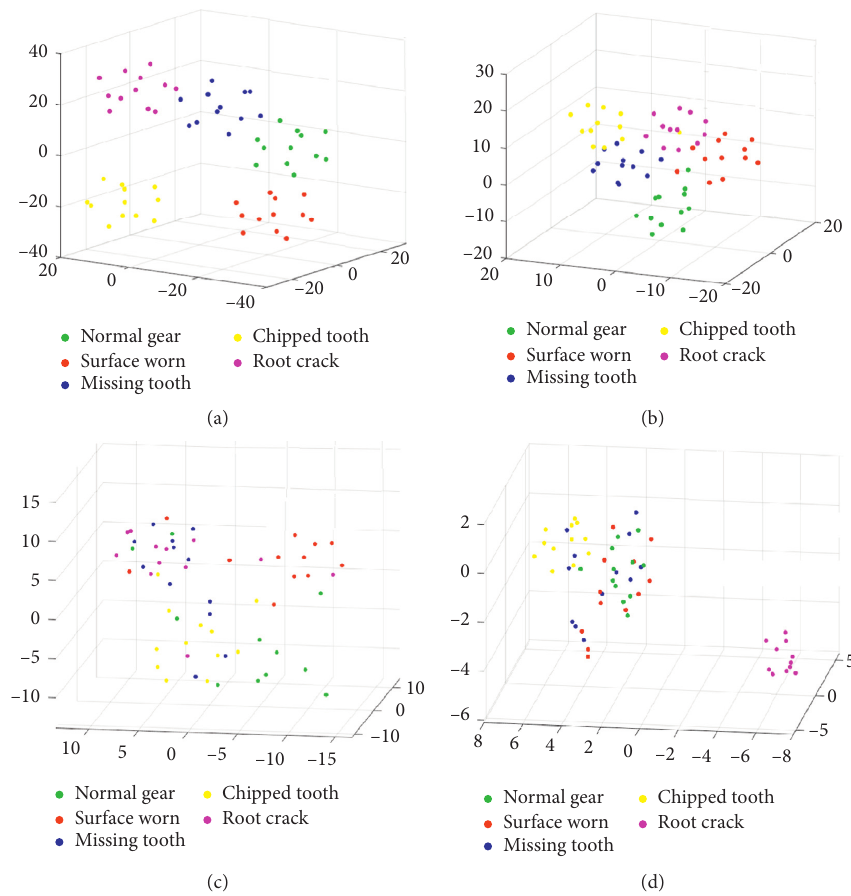
Figure 11: Classification results visualization. (a) Classification results of the proposed method. (b) Classification result of traditional SAE. (c) Classification results of PCA. (d) Classification results of